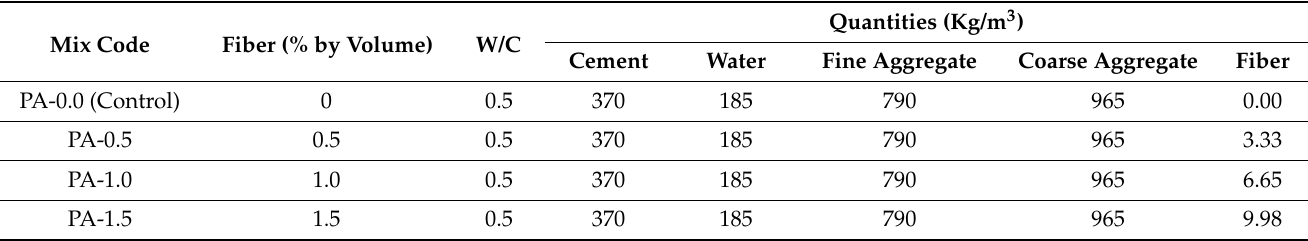
Table 2. Details of concrete